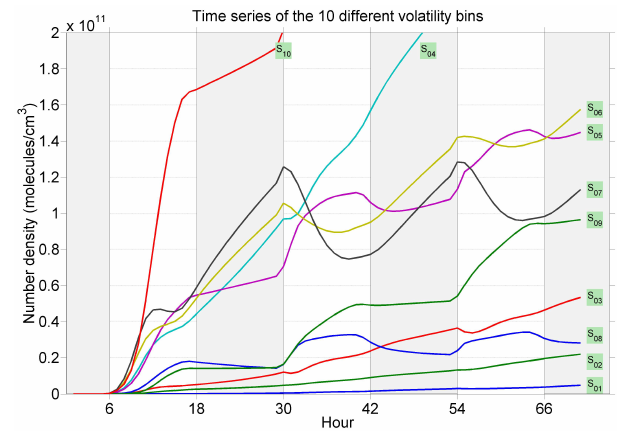
Fig. 2. Diurnal profiles for the 10 lumped species from one α - pinene oxidation scenario lasting for 72h. The shaded areas in- dicate night